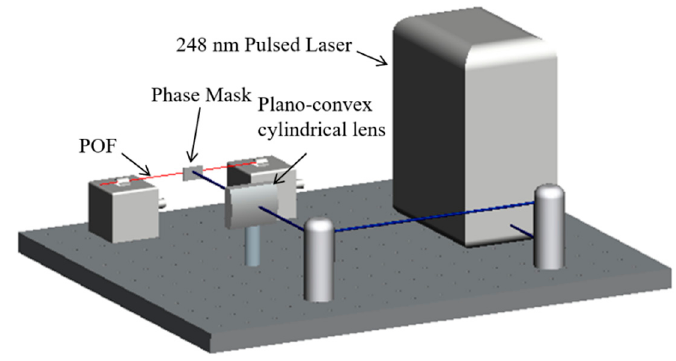
Figure 1. Typical POF FBG irradiation system; image adapted from [58].